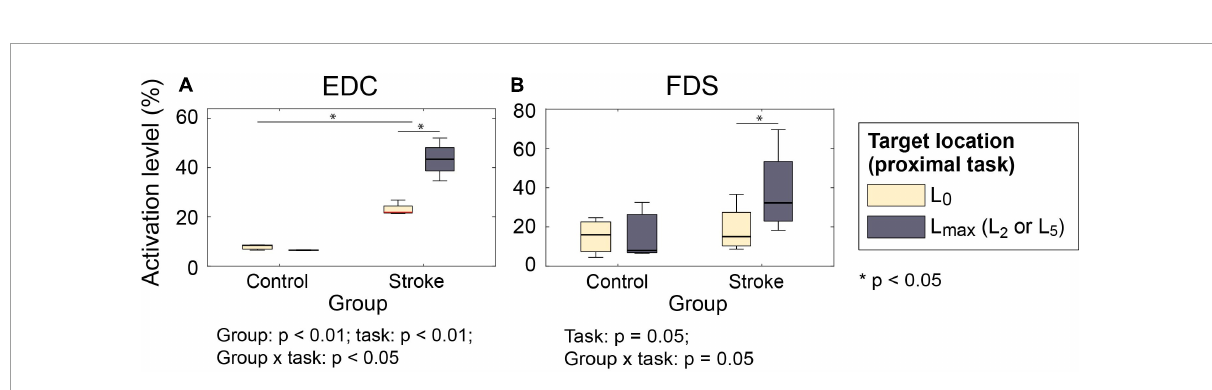
FIGURE4 Muscle activation level during hand open phase under two proximal task conditions ( P HOr T 1 vs. P HOr T 2 ). (A) EDC; (B) FDS. For both muscles, the increase in the activation level was significantly greater for stroke survivors (group × proximal task: p < 0.01 for EDC and p = 0.05 for FDS) (EDC, extensor digitorum communis; FDS, flexor digitorum